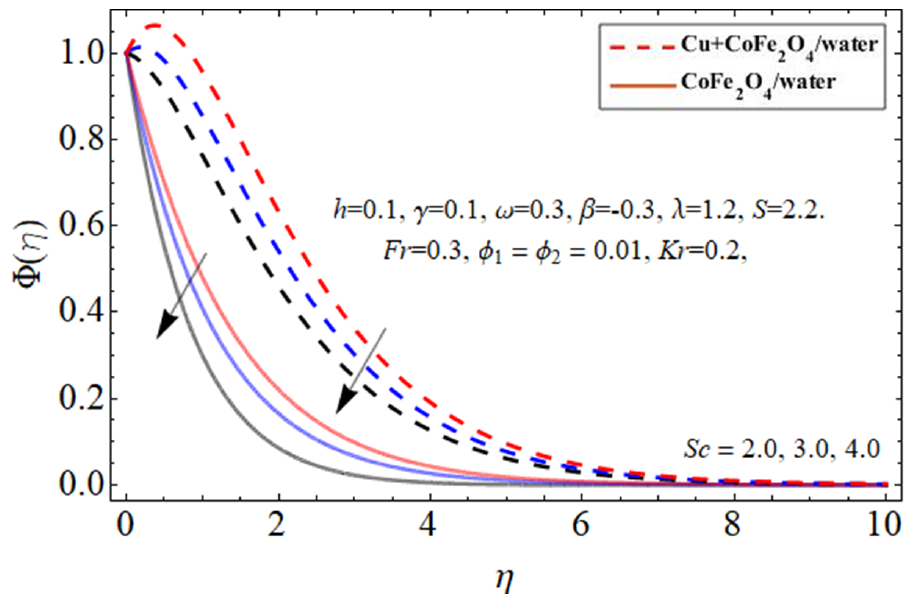
( ) ηΦ profile versus the Schmidt number Sc . Figure 14. The nature of concentration Φ ( η ) profile versus the Schmidt number Sc .